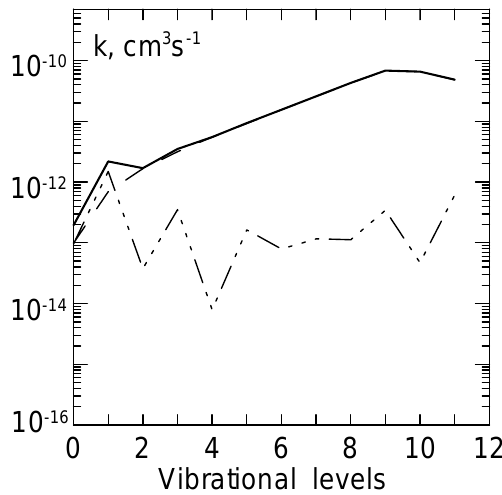
Fig. 1. The calculated quenching rate coefficients of O 2 (A 3 6 + u , v =0-10)+O 2 (solid line) are compared with experimental data by Knutsen et al. (1994) (triangles), Copeland et al. (1994) (star), Slanger et al. (1984) (cross). Dashed line and dash and three dot- ted line are the contributions of intramolecular and intermolecular electron energy transfer processes, respectively.